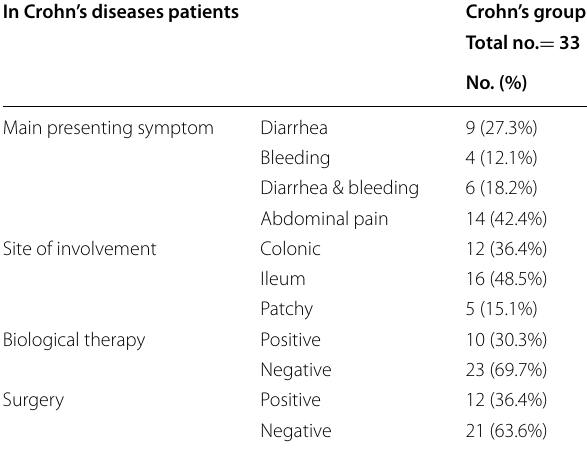
Table 10 Clinical characteristics of Crohn’s disease